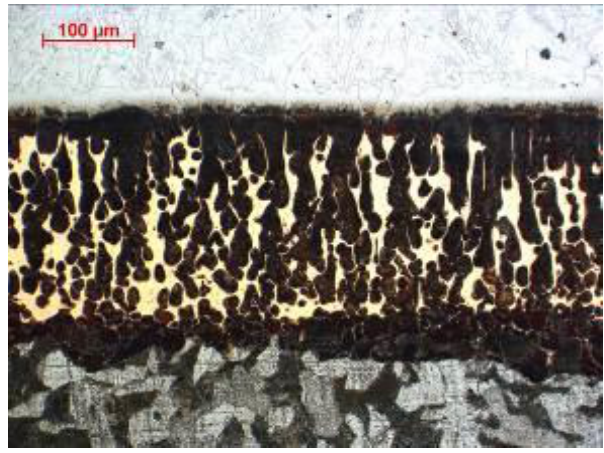
Figure 2. Microstructure of the intermediate layer of ABRECOPLATE cross-section.